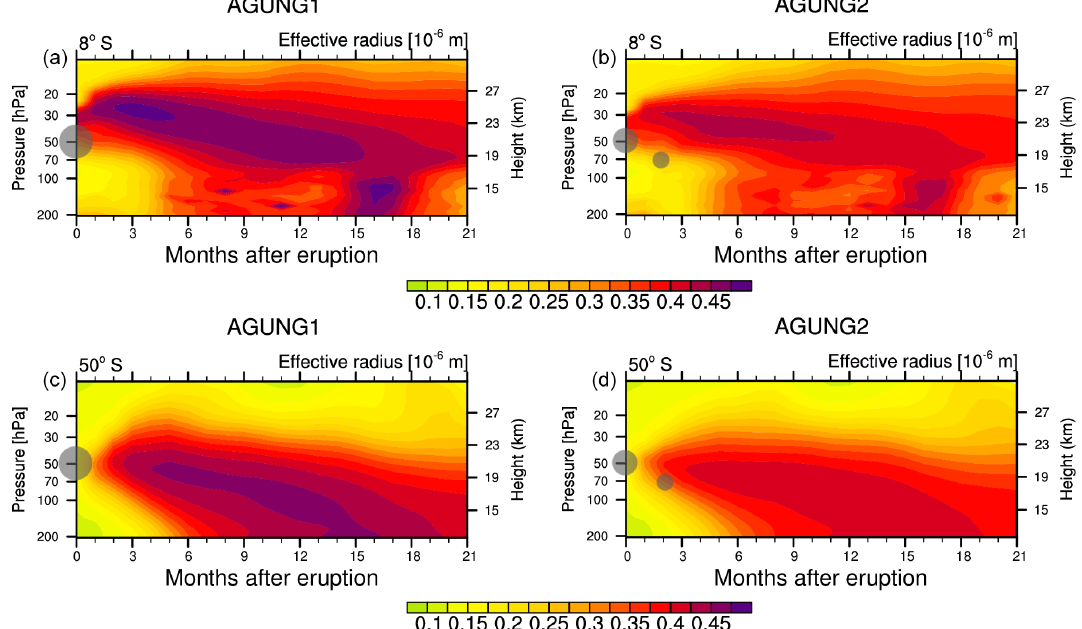
Figure 4. Time series of monthly mean effective radius (µm) of sulfate at the grid point corresponding to 8 ◦ S (a, b) and 50 ◦ S (c, d)